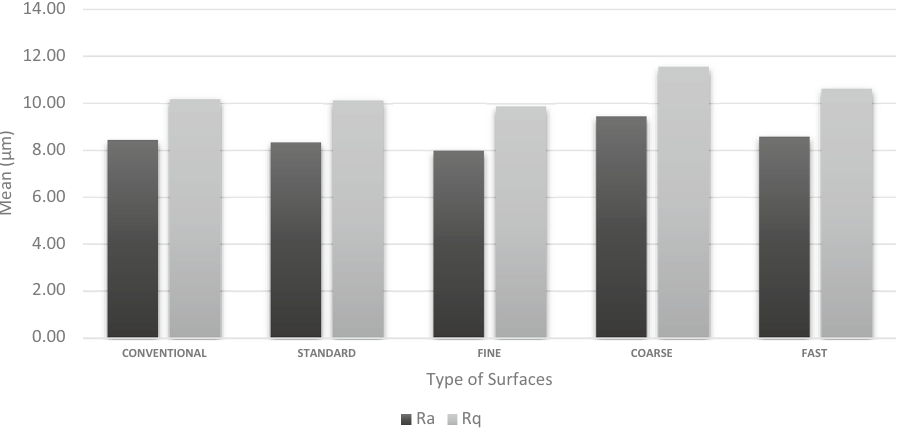
Figure 3. Line graph showing the Ra values of all surface samples (n =